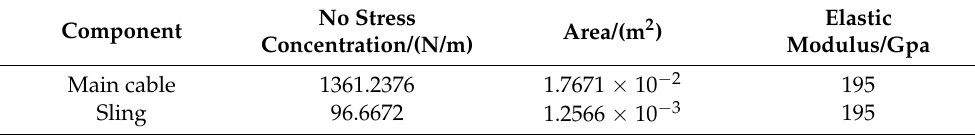
Table 2. Material